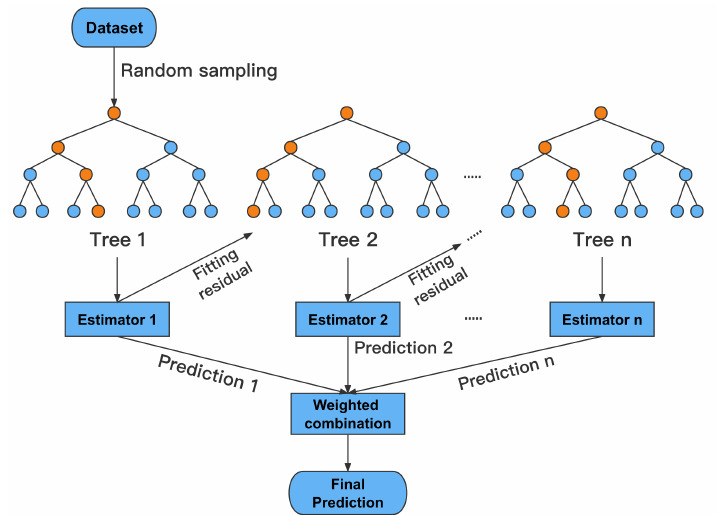
Figure 4. Schematic diagram of